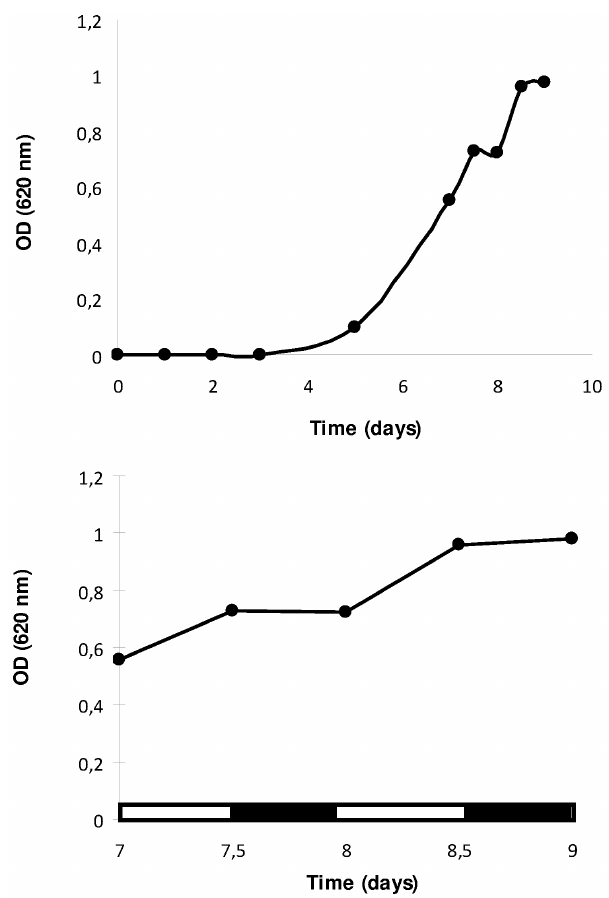
Figure 3. Growth curve of A . platensis under a 12-hour LD cycle.